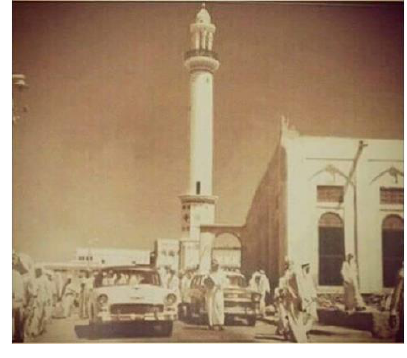
Figure 15. 1959 Freej Alfadheel/ (freej.alfadheel, 1959)